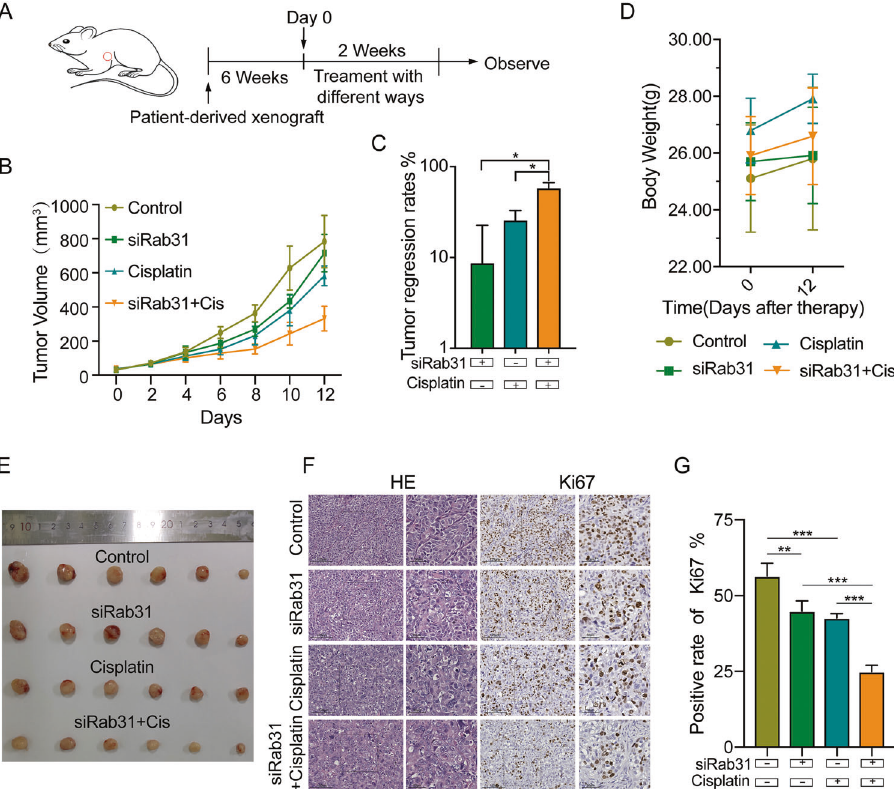
Fig. 5 Rab31 depresses sensitivity to cisplatin in a PDX model of human STAD. A Flowchart of our animal experiments. B Volume of tumor xenografts was measured every other day in the different treatment groups. C Tumor regression rates ( *p < 0.05, cisplatin plus Rab31 siRNA vs. Rab31 siRNA alone; *P < 0.05, cisplatin plus Rab31 siRNA vs. cisplatin alone). D The body weight was measured in the different treatment groups. E Representative images of tumors at day 12. F Rab31 levels were signi fi cantly associated with expression of Ki67. Representative images of tumors at day 12 are shown. Scale bar: 125 μ m (left panel); 50 μ m (right panel). G Positive rate of Ki67 ( **P < 0.01, control vs. Rab31 siRNA alone; ***P < 0.001, control vs. cisplatin alone; ***P < 0.001, cisplatin plus Rab31 siRNA vs. Rab31 siRNA alone; ***P < 0.001, cisplatin plus Rab31 siRNA vs. cisplatin